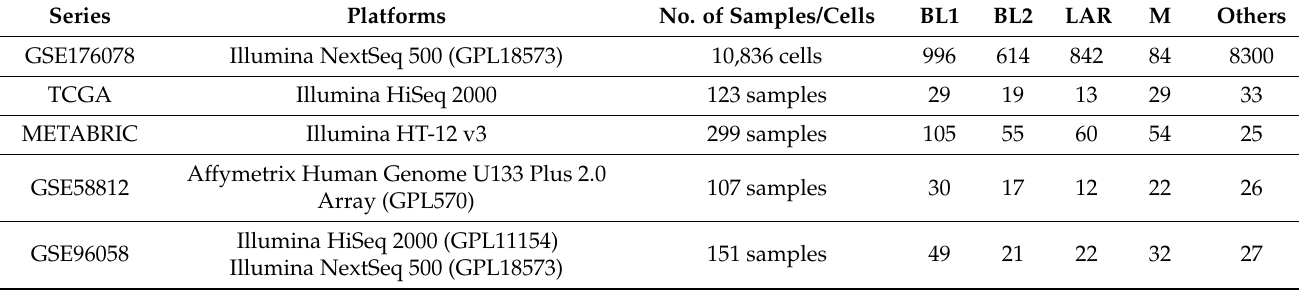
Table 1. Summary of the TNBC subtype patients/epithelial cells in the datasets used in this study.